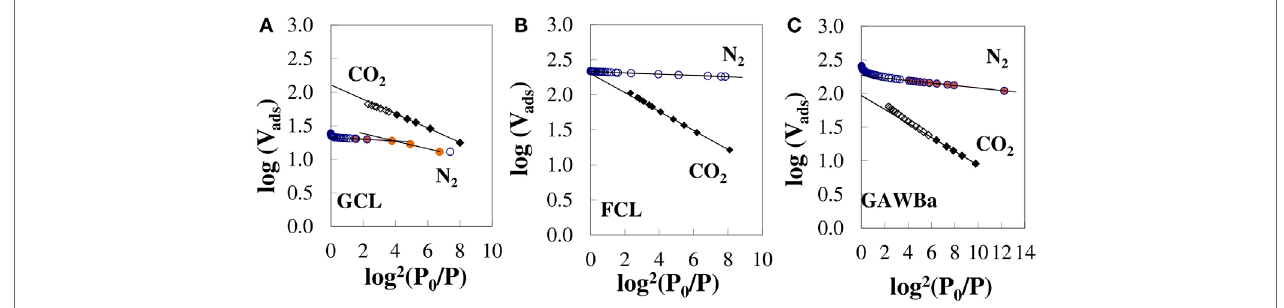
FigUre 4 | characteristic n 2 ( − 196°c) and cO 2 (0°c) D–r curves for samples (a) gcl, (B) Fcl, and (c) gaWBa ( β n2 = 0.33; β cO2 = 0.35)